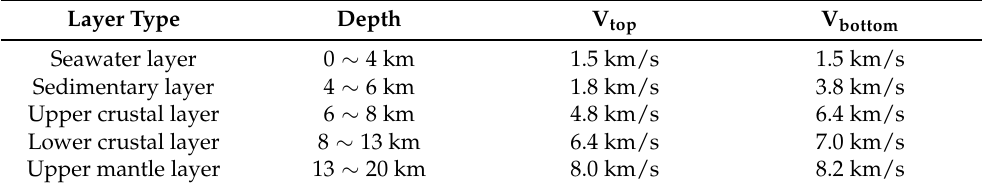
Table 1. Initial two-dimensional velocity model for travel time forward